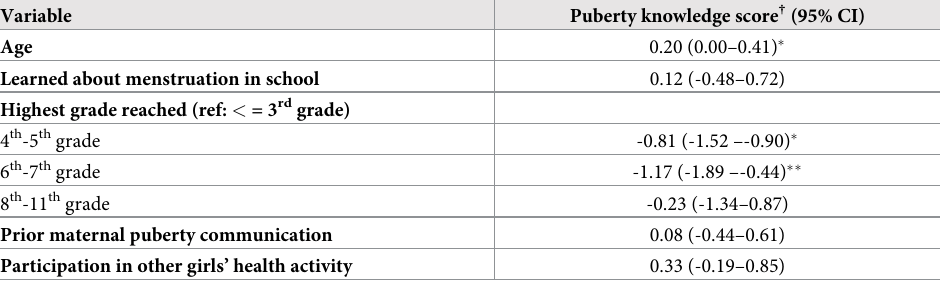
Table 7. Multivariate analysis for puberty knowledge score among girls enrolled in school who had reached men- arche (N =